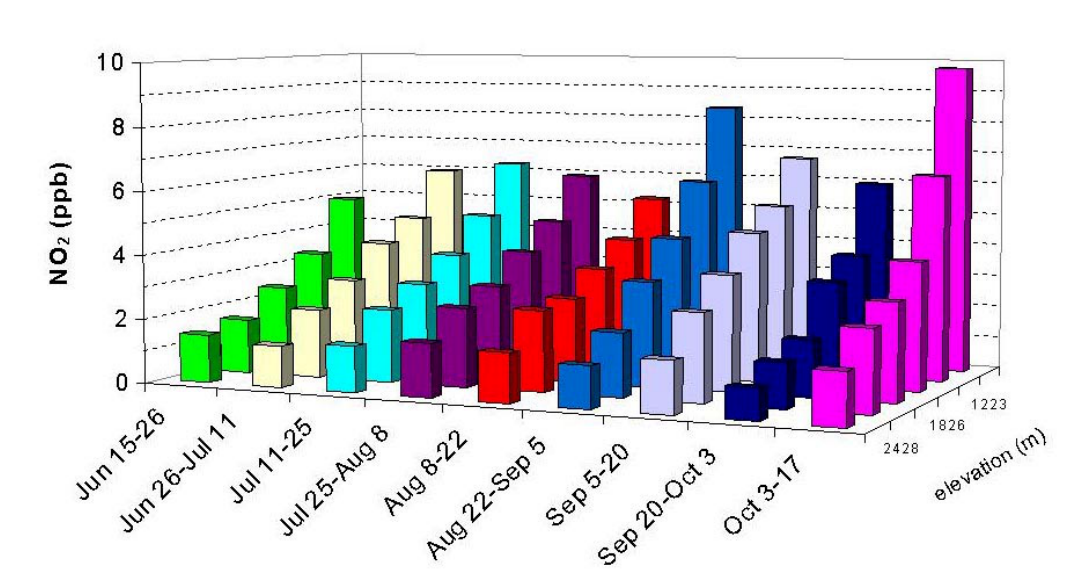
FIGURE 7. Concentrations of NO 2 (ppb) determined with passive samplers exposed during 2-week long periods during summer 2000. Nitric Acid Vapor samplers was 11% among co-located filters. Both elevation and time Average precision of HNO 3 exposure ( p < 0.001). Summer average HNO concentrations had significant effects on HNO 3 3 were negatively correlated with elevation (R 2 = 0.93, Fig. 8) ranging from 5.1 µg m -3 at the lowest site to 1.9 µg m -3 at the highest site (Table 1). The two sites located at the lower elevations had consistently higher HNO concentrations than the rest of the sites up on the gradient. All the sites 3 concentrations in the middle of the season (from July 11 to August 22) and had the highest HNO 3 the lowest values at the beginning of autumn and during the period August 22 to September 5 (Fig. 9). Two-week averages ranged between 6.5 µg m -3 registered at the lowest site of the gradient during July and August and 0.66 µg m -3 recorded in October at 2111 m of elevation.